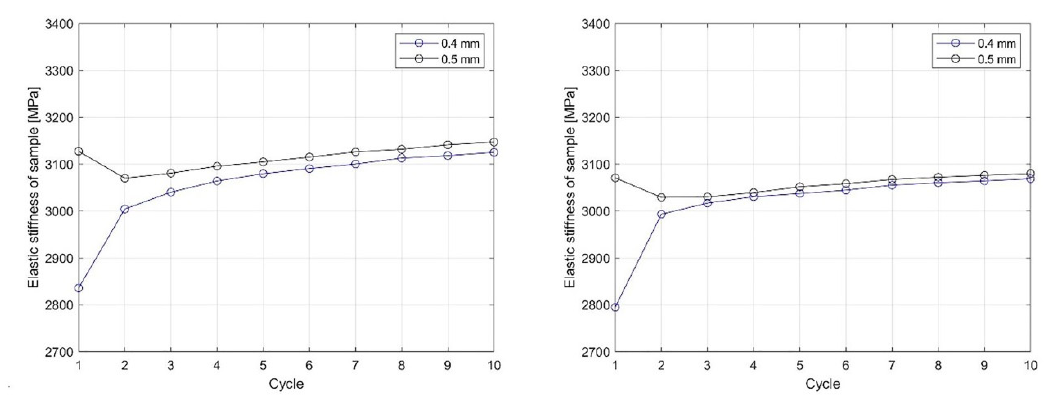
Figure 21. The dependency of the ES of the sample on the number of cycles and the loading path for 1.6 mm ( left ) and 2.4 mm ( right ) ILD (initial nominal displacement 0.4 mm).